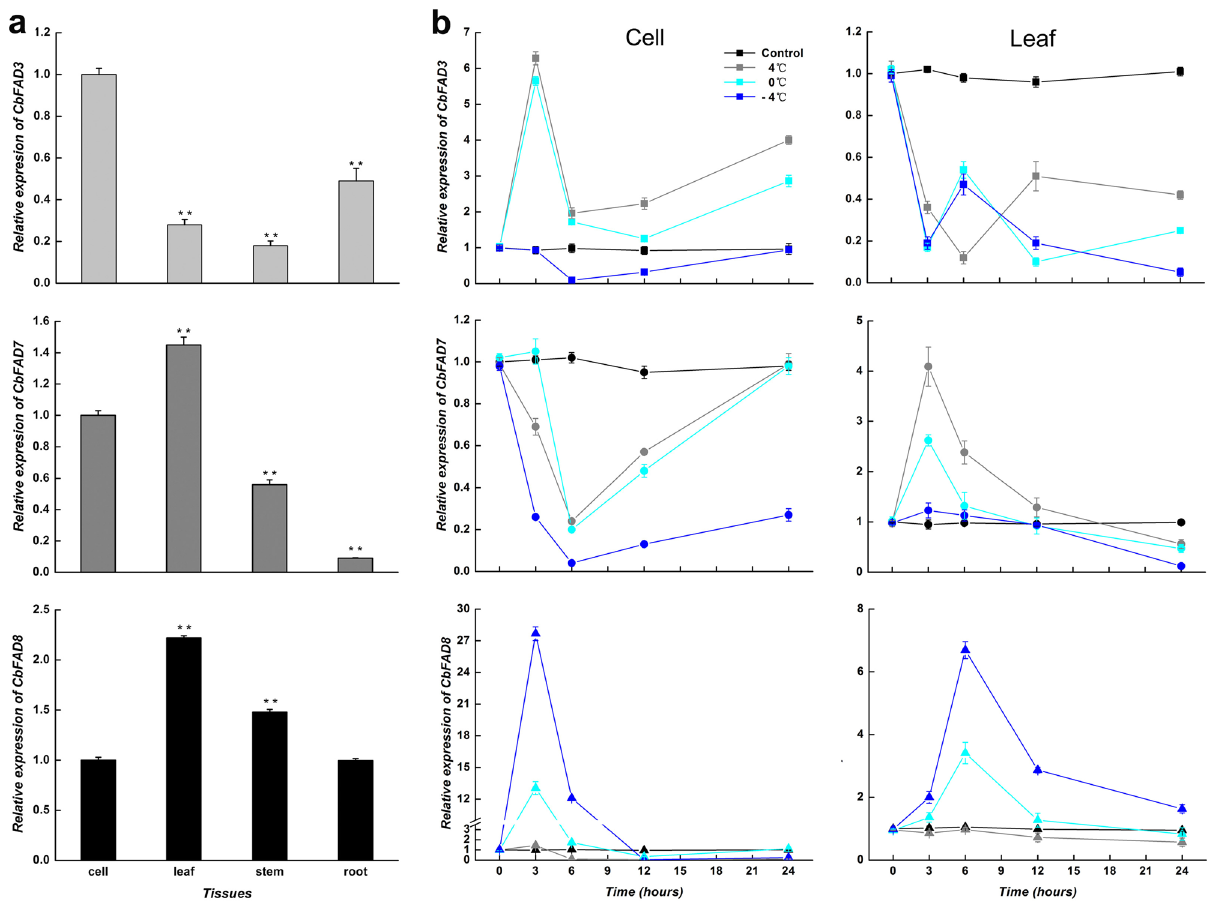
Figure 3. Expression patterns of ω-3 CbFAD genes in C. bungeana. ( a ) Tissue-specific expressions of CbFAD3 , CbFAD7 and CbFAD8 . Data were presented as relative expression ratios being compared with the expression levels of corresponding genes in suspension-cultured cells, which were set at a value of 1. ( b ) Cold-responsive expressions of CbFAD3 , CbFAD7 and CbFAD8 in suspension-cultured cells and the leaves from regenerated plants. Data were presented as relative expression ratios being compared with the expression levels of corresponding genes before treatment (0 h), which were set at a value of 1. Each value represents the mean ± SE of three replicates. The relative expressions of CbFAD3 , CbFAD7 and CbFAD8 are indicated by square, circle and triangle,